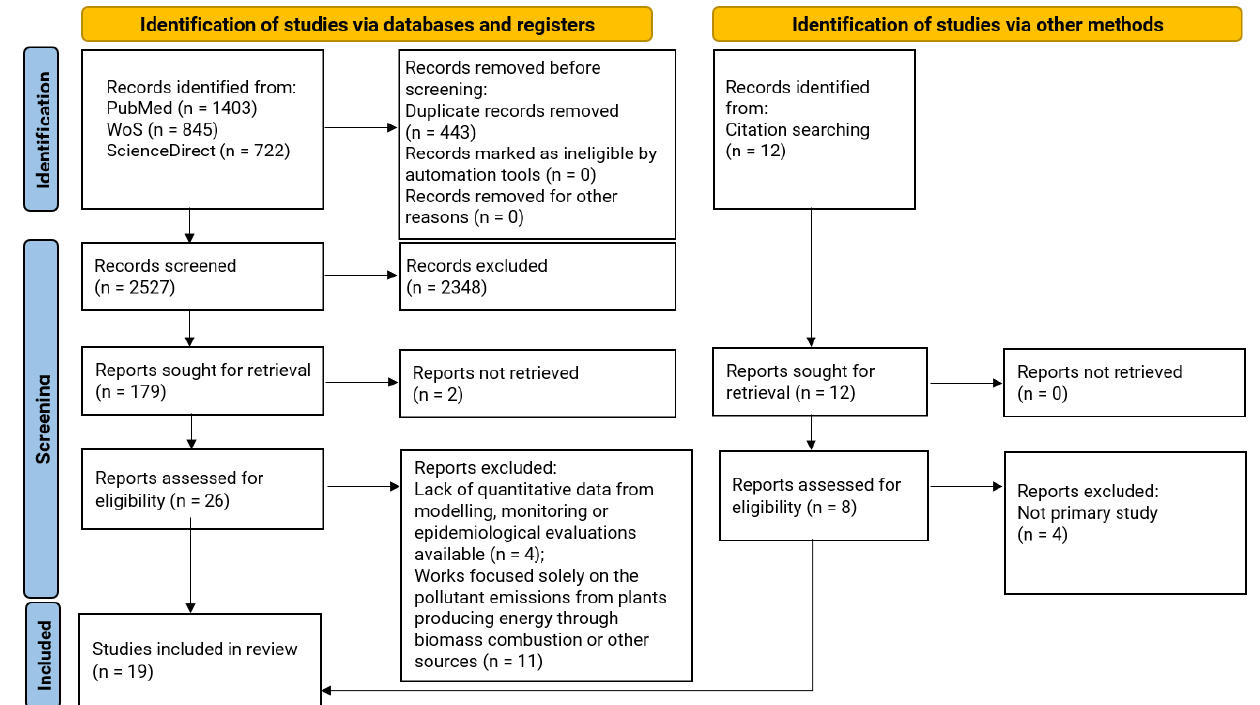
Figure 2. Study selection process. For more information on this flowchart, see [16].